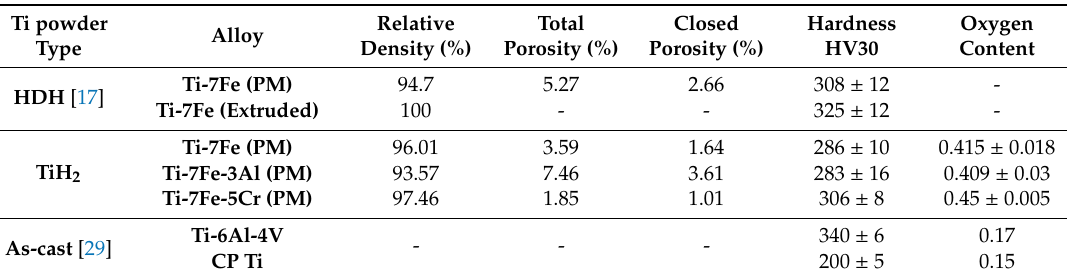
Table 4. Relative density, porosity, and Vickers hardness of the TiH 2 samples and from HDH powders from previous